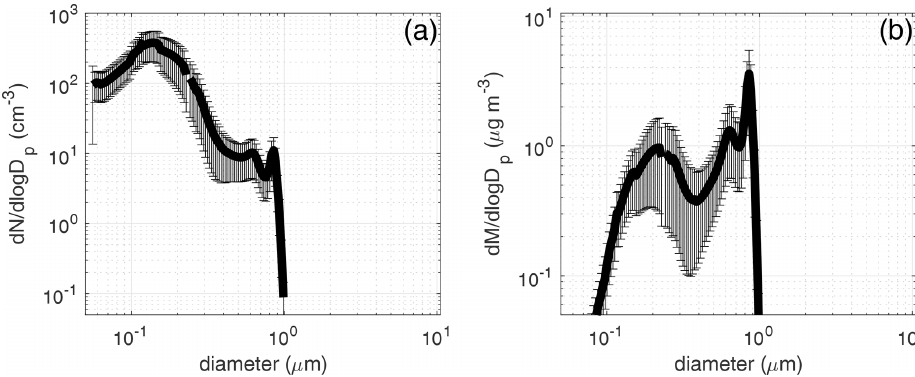
Figure 2. Average (solid black line) and variability (1 standard deviation; error bars) of the UHSAS (a) number (cm − 3 ) and (b) mass (µgm − 3 ) size distributions during the clean marine background season of LASIC (November 2016–May 2017).